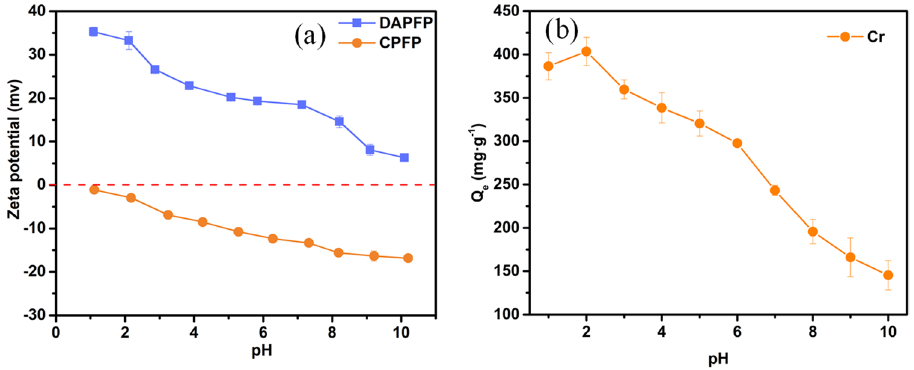
Figure 2. ( a ) Zeta potential plot of CPFP and DAPFP at different pH values; ( b ) adsorption perfor- mance of DAPFP for Cr (VI) at different pH values. mance of DAPFP for Cr (VI) at different pH